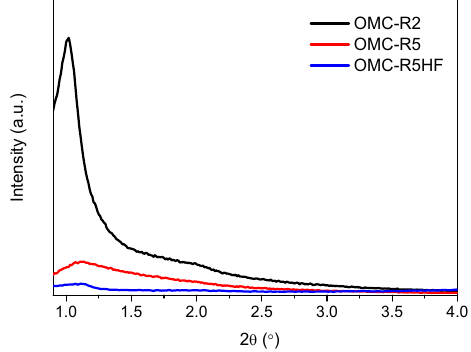
Figure 1. XRD patterns of ordered mesoporous carbon (OMC) supports.